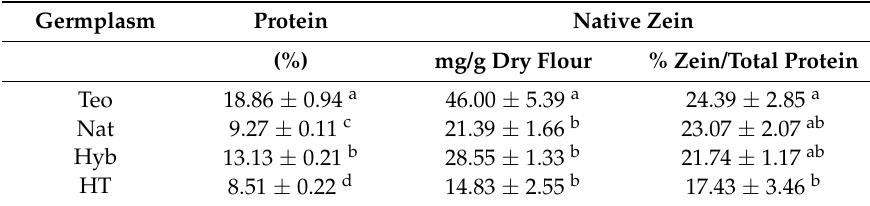
Table 1. Quantification of protein and native zein in flour from diverse maize germplasm. Germplasm